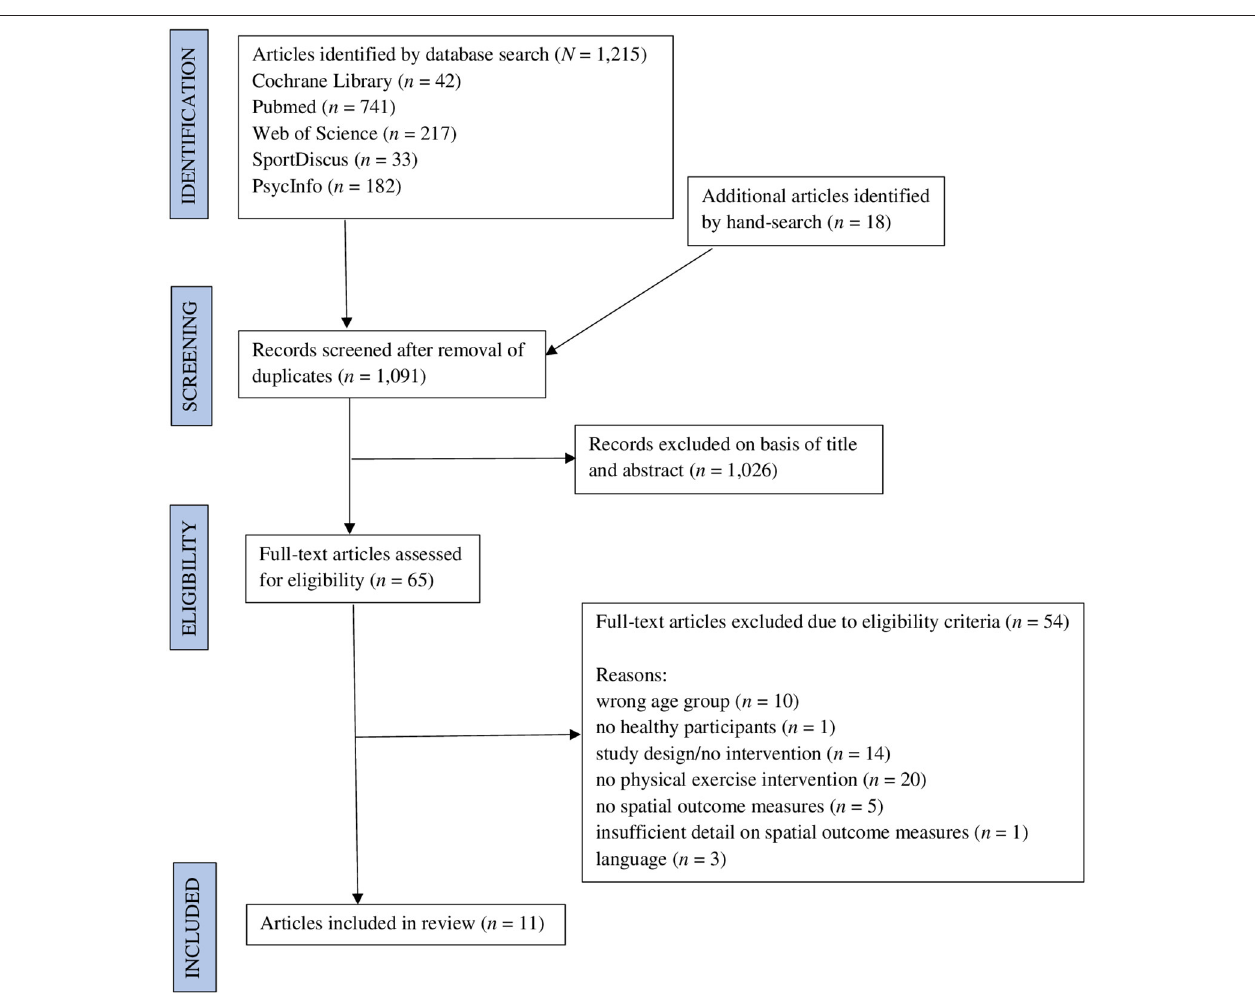
FIGURE 1 | PRISMA flow